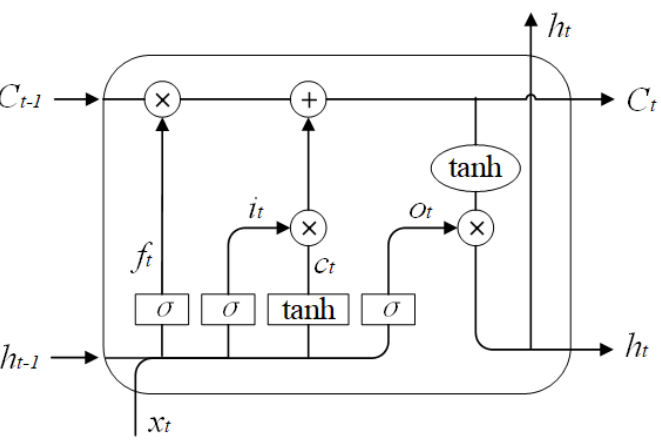
Figure 1. Structure diagram of LSTM.